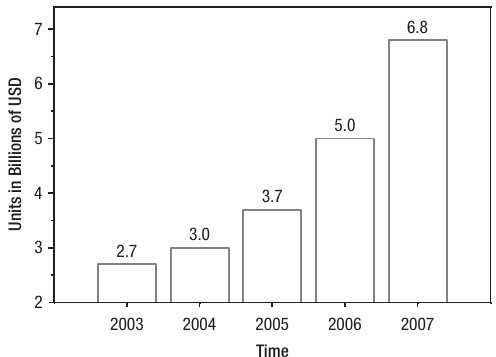
Fig. 1. Market Scale of Biotech Pharmaceutical Industry in China